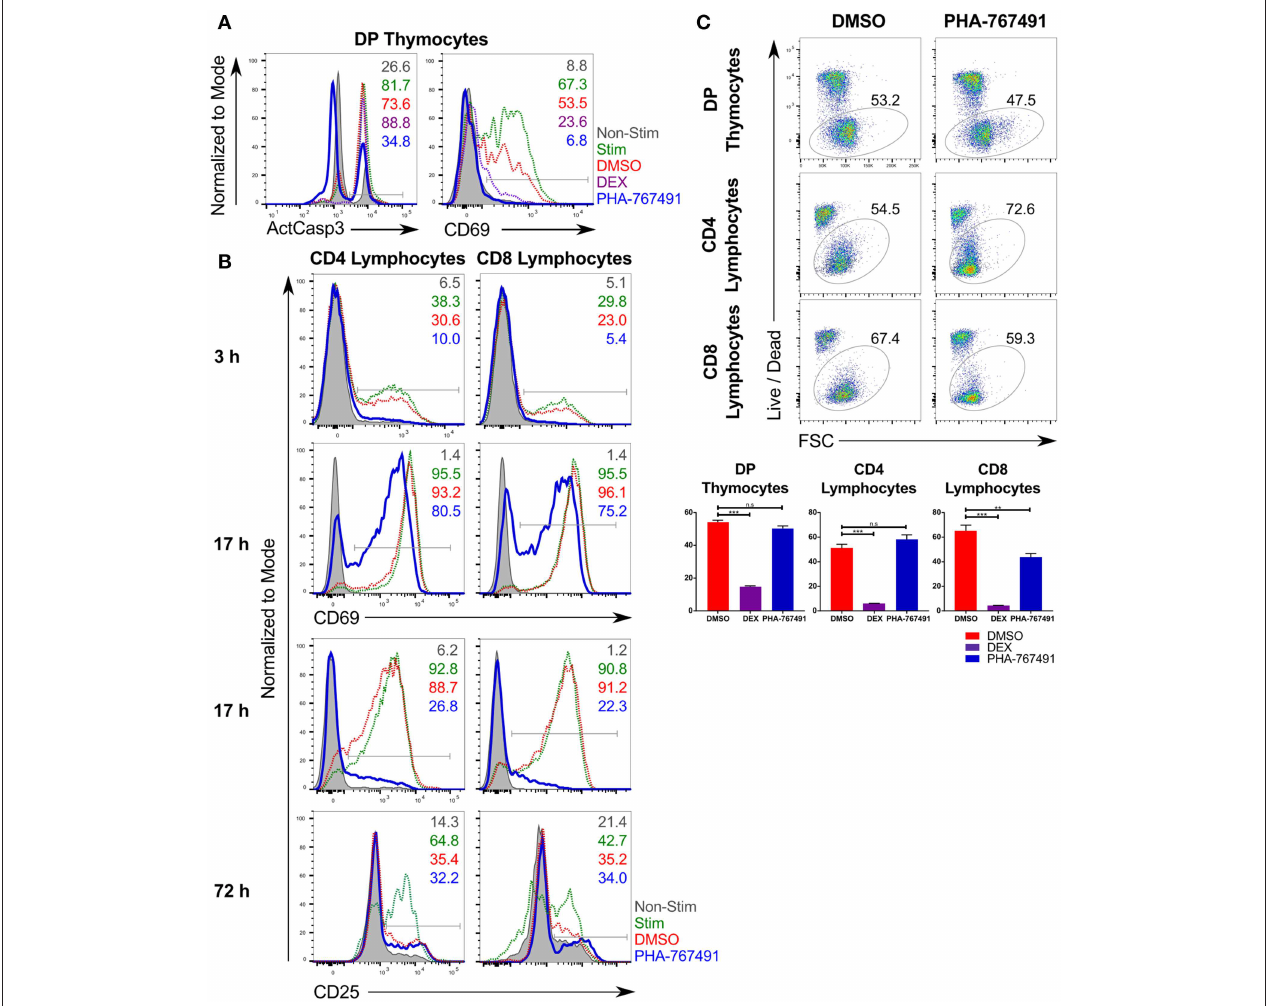
FIGURE 1 | PHA-767491 suppresses T cell activation. (A) PHA-767491 suppresses activation of caspase-3 and expression of CD69 in mouse thymocytes stimulated with anti-CD3/CD28 beads for 17h. (B) PHA-767491 suppresses expression of CD69 and CD25 in mouse peripheral T lymphocytes stimulated with plate-bound anti-CD3 antibodies for 3, 17, or 72h. (C) PHA-767491 does not affect the viability of primary mouse thymocytes or stimulated peripheral T lymphocytes after 17h incubation. Cells were incubated with 1% DMSO (DMSO; negative vehicle control), 5 µ M dexamethasone (DEX; positive control), or 10 µ M PHA-767491. Viable cells were detected based on Live/Dead staining. Data shown is representative of at least three independent experiments. Bar charts are represented as mean ± SEM. Statistical significance was determined by unpaired two-sided Student’s t -test (n.s, non-significant; ** p < 0.01; *** p < 0.001). The percentages of the positive population of each sample are represented in each graph according to their respective colors. ActCasp3, active caspase-3; non-stim, non-stimulated; stim: stimulated; DMSO, stimulated vehicle controls treated with DMSO; DEX, treated with dexamethasone.